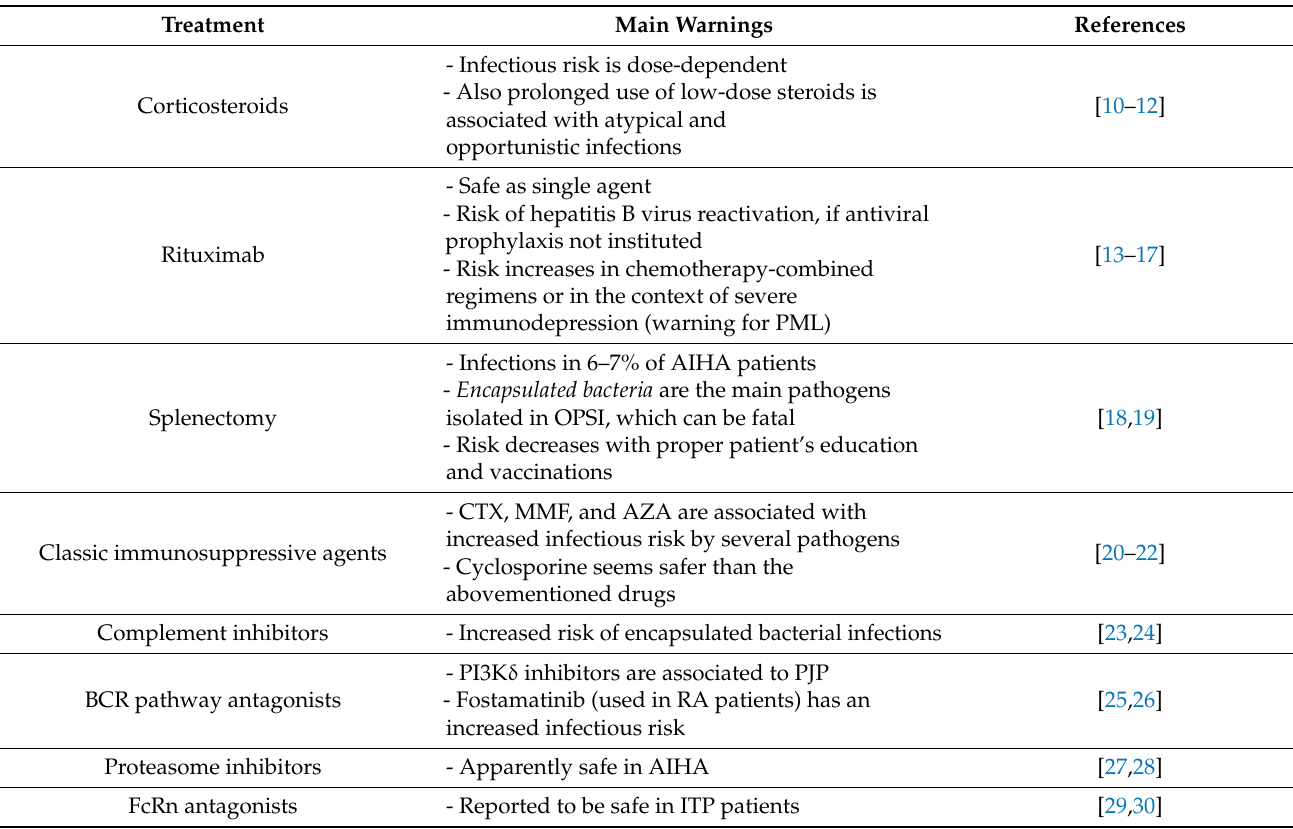
Table 1. Infectious risk associated with autoimmune hemolytic anemia (AIHA)